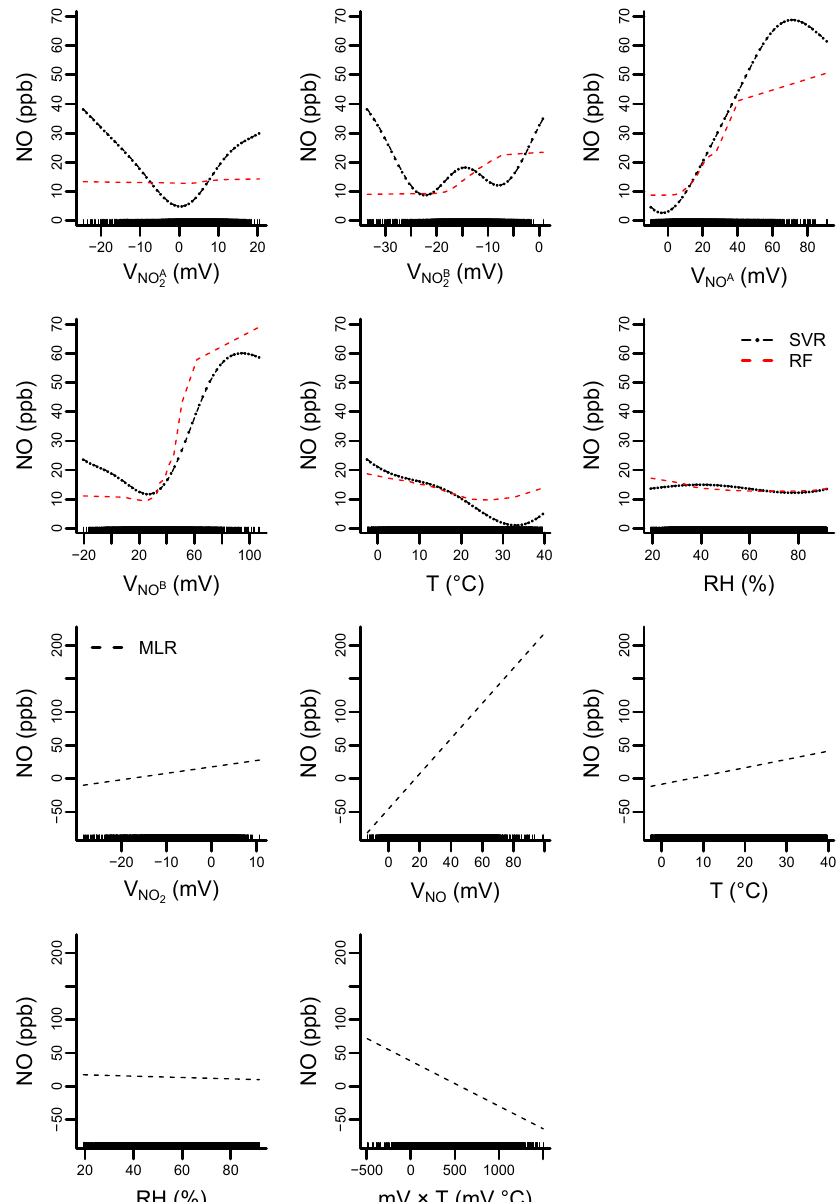
Figure 1. Partial plots for SVR, RF and MLR for the calibration dataset from SU009, NO. Rug on the abscissa indicates the range of the